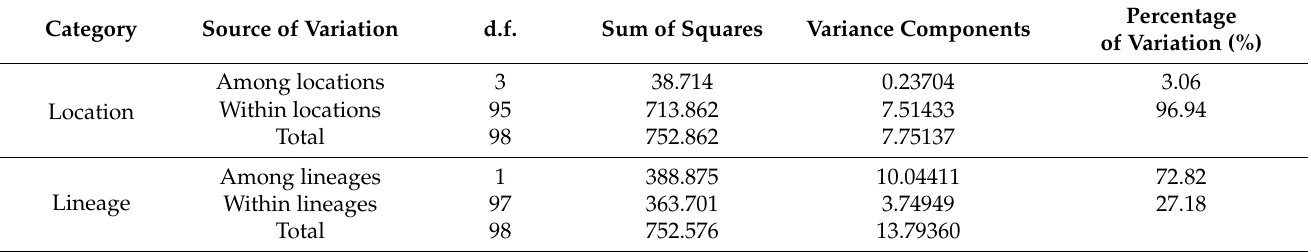
Table 4. Analysis of molecular variance analysis among locations of Schizothorax kozlovi from the upper Yangtze River based on the concatenated Cyt b and COI genes sequences.